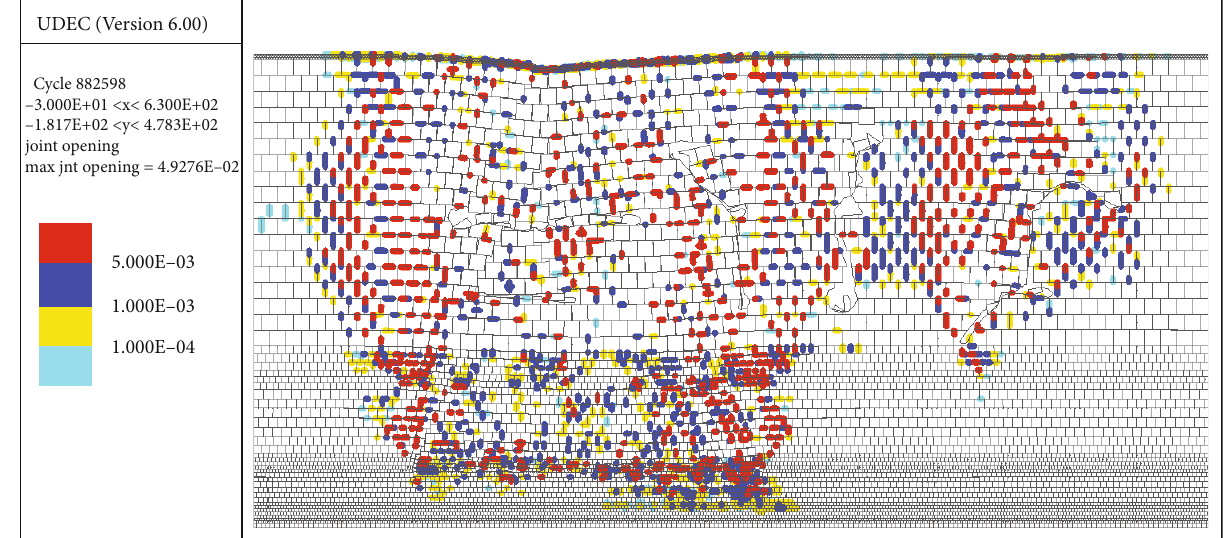
Figure 7: Mining-induced fracture fi eld (mining distance is 320 m in 4# coal seam).